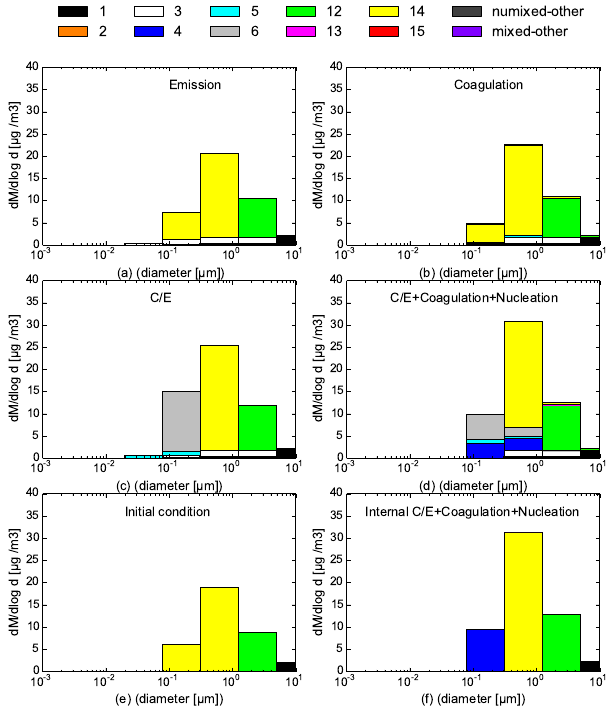
Figure 7. Result mass distributions of externally mixed parti- cles as a function of particle diameter for the different chemi- cal compositions for six different simulation scenarios: (a) emis- sion only; (b) emission + coagulation; (c) emission+C / E; (d) emis- sion + coagulation + C / E + nucleation; (e) initial condition; and (f) internal mixing